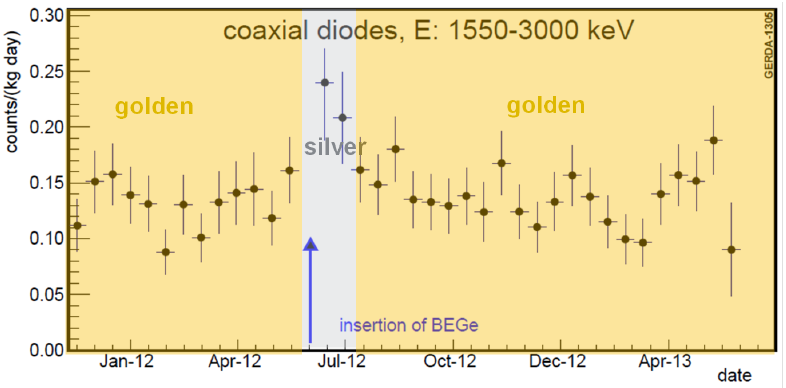
Figure 8. The time profile of the Phase I BI along the GOLDEN and SILVER data sets: the increase of the background index in the C OAX detector at the time of the pilot enr BEG E string insertion is due to a minimal quantity of Rn